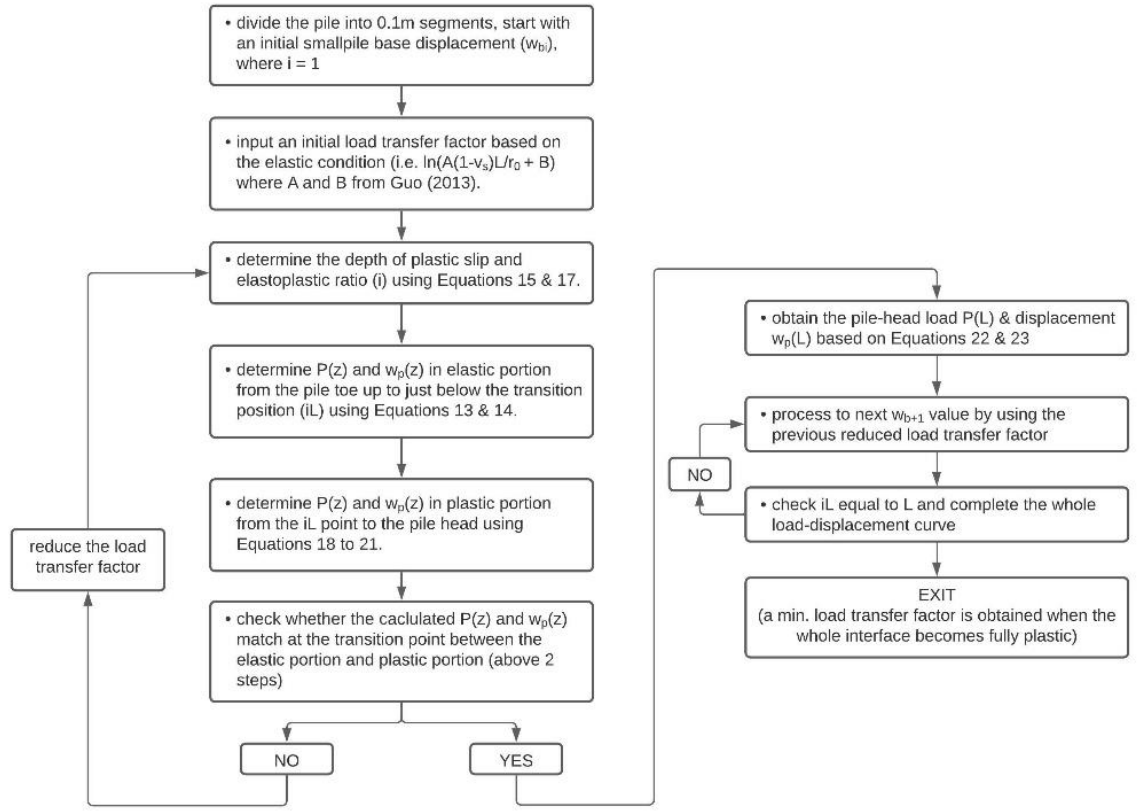
Figure 14. Flowchart for the iterative analytical procedure.